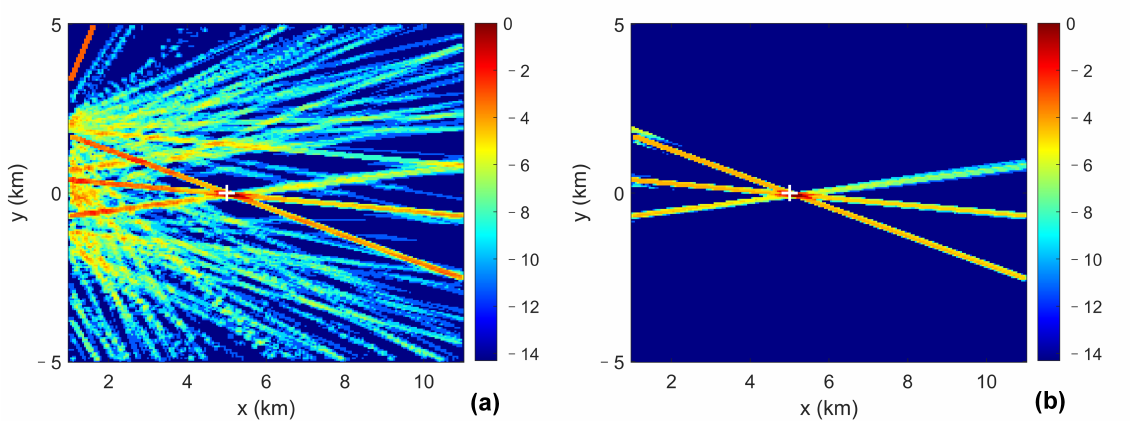
Figure 7. (Color online) ( a ) The inter-array intersection pattern of the Basic-FLFL method; ( b ) the inter-array intersection pattern of the proposed HT-FLFL method. The white plus markers indicate the true position of the